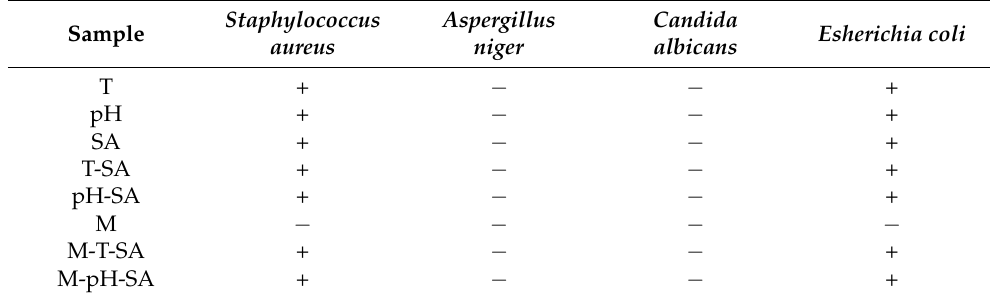
Table 4. The inhibition growth of the chosen microorganisms caused by the used materials.